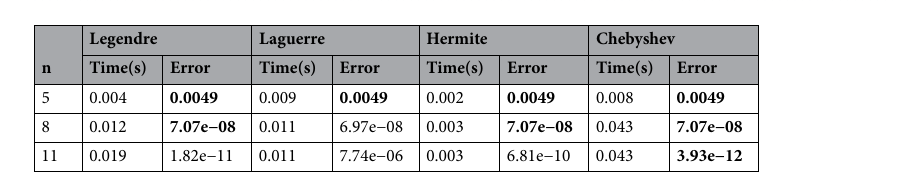
Figure 3. Error graph for different orthogonal neural networks with different numbers of neurons for Example 6.1.